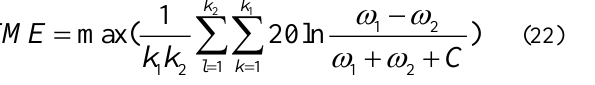
Table 2. Results with different